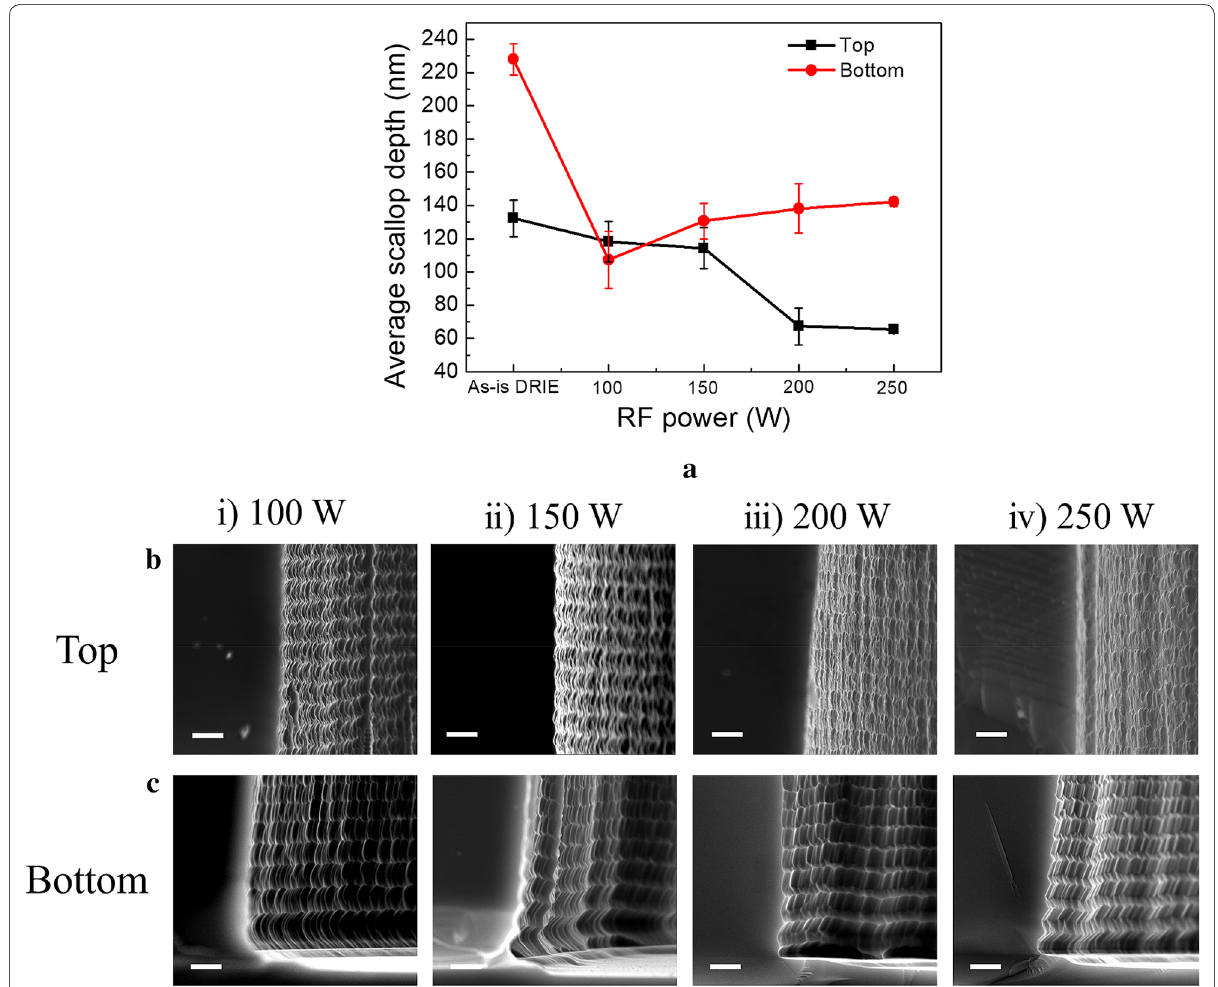
Fig. 3 Scallop smoothing results after varying the RF power during the RIE process. a Average scallop depths of trenches as a function of each RF power condition. As‑is DRIE represents the trench before scallop smoothing. The error bar under each condition represents the standard error of 5 averaged scallop depths. SEM images of sidewalls ( b ) near the top area and ( c ) at the bottom of the trenches for each RF power value. All scale bars in SEM images are 1